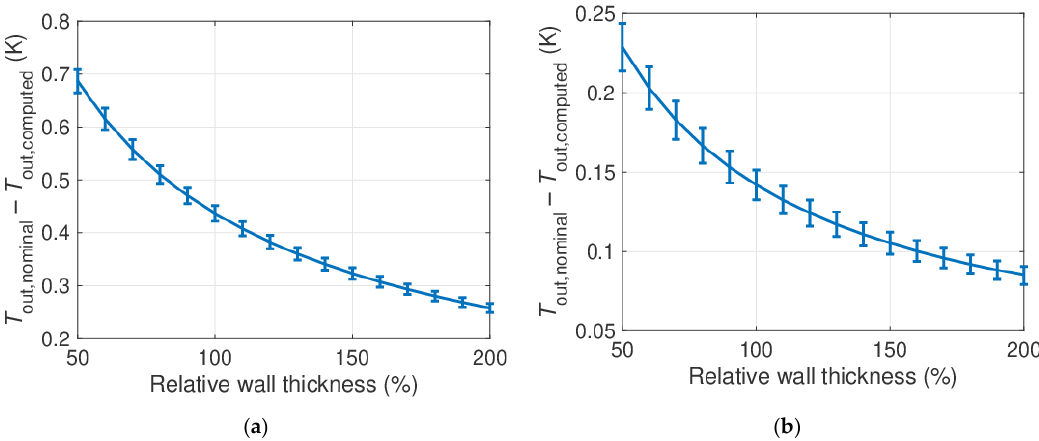
Figure 14. Difference between design outlet temperature (328 °C) and its computed value, as a function of the wall thickness, for the case with no radiation and adiabatic PbLi manifolds: ( a ) FW manifolds; ( b ) BZ manifolds.